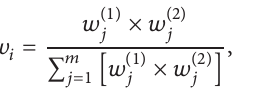
and 𝑊 refer to the weights determined with the analytic hierarchy AHP CV